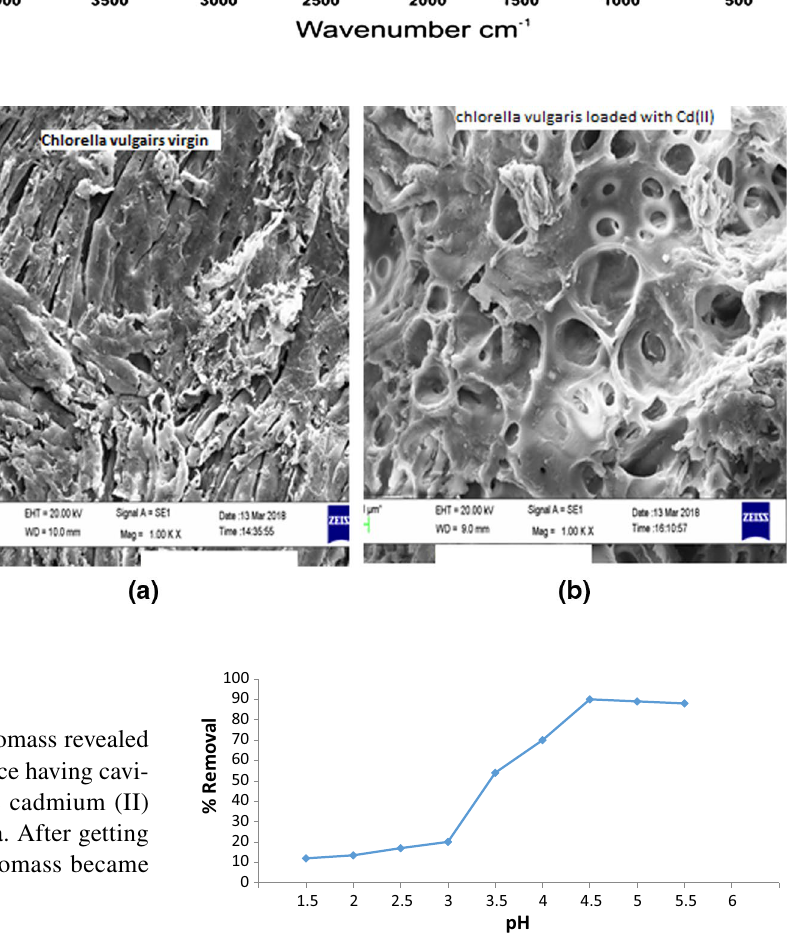
Fig. 4 Effect of pH on adsorption of Cd (II) on to Chlorella vulgaris biomass: C i = 100 mg/L, dose = 1 g/L, contact time = 2 h and room